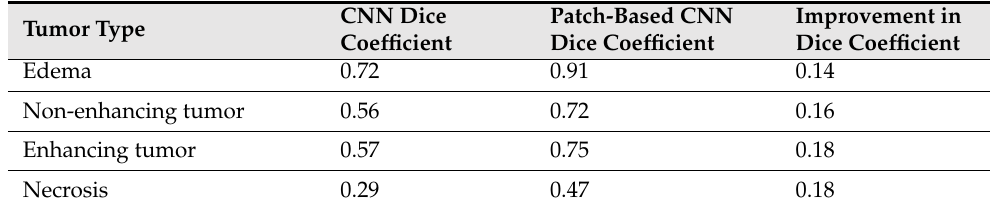
Table 16. Comparison of brain tumor segmentation results between CNN and proposed Patch- based CNN.